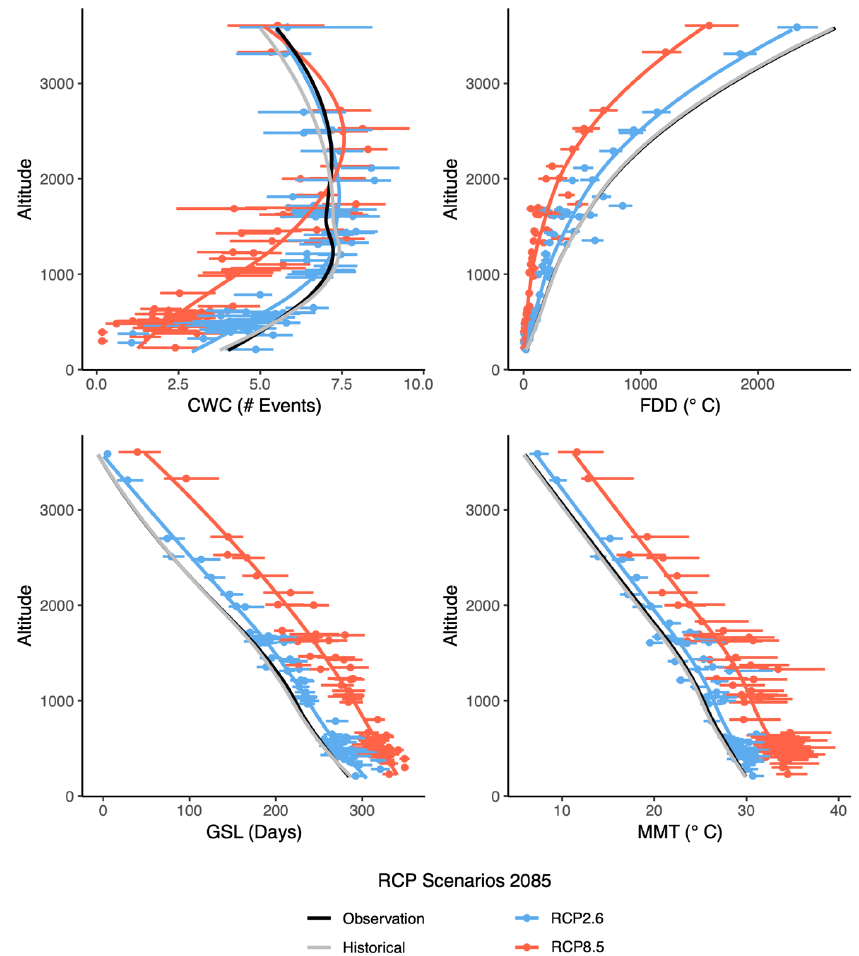
Figure 5. Relationship between elevation (y-axis) and the corresponding values of the indices (class A: CWC, FDD, GSL and MMT; x-axis). The grey line represents the median of the historical quantile-mapped simulations, the black line denotes the observations (both for the period 1981–2010). All lines were obtained by fitting a local regression trendline through the observations and the simulated median values (indicated by the markers). The blue (red) line represents the RCP2.6 (RCP8.5) scenario with corresponding median values (dots) per station and scenario. Horizontal bars indicate the multi-model range for the future period (5 to 95% confidence interval) at di ff erent stations across